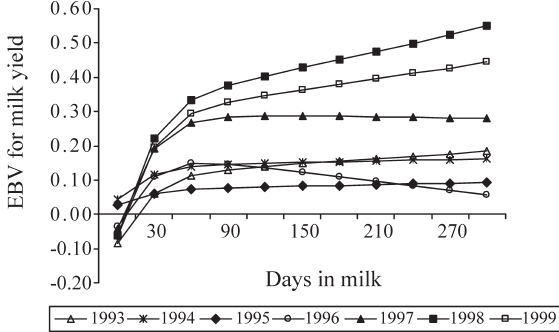
Figure 8 - Average estimated breeding values for milk yield across lacta - tion of cows and sires according to the birth year of cows. Table 5 - Average estimated breeding values of sires for persistency of lactation